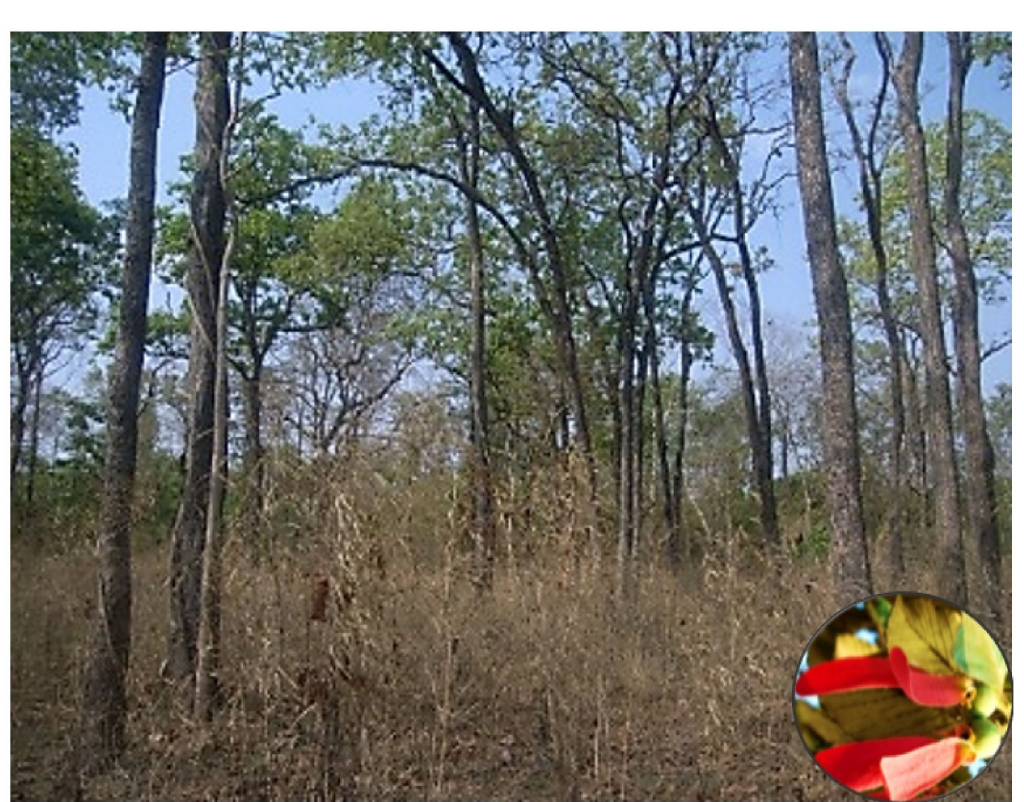
Figure A4. Dipterocarpus obtusifolius (mixed semi-evergreen